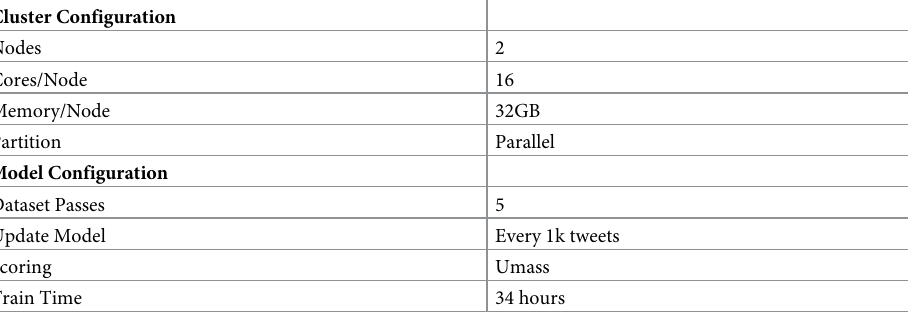
Table 3. Cluster & model